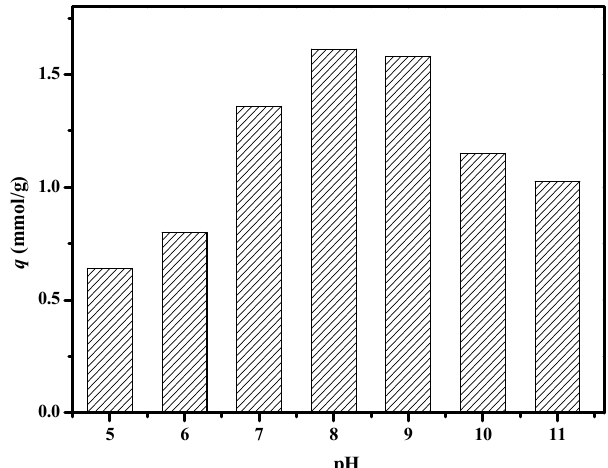
Figure 13. E ff ect of pH value on boron uptake of PSF-diol membrane ( C 0 = 300 mg / L, T = 25 ◦ C). Figure 13. Effect of pH value on boron uptake of PSF-diol membrane ( C 0 = 300 mg/L, T = 25 °C).